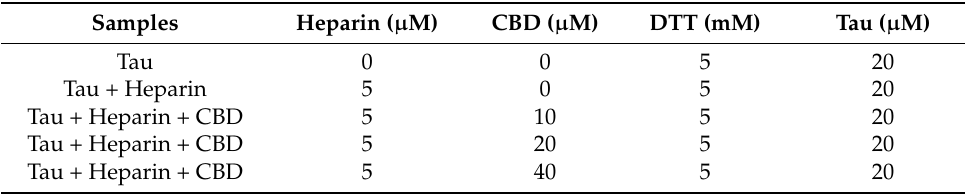
Table 1. Tau protein aggregates preparation in the absence and presence of various concentrations of